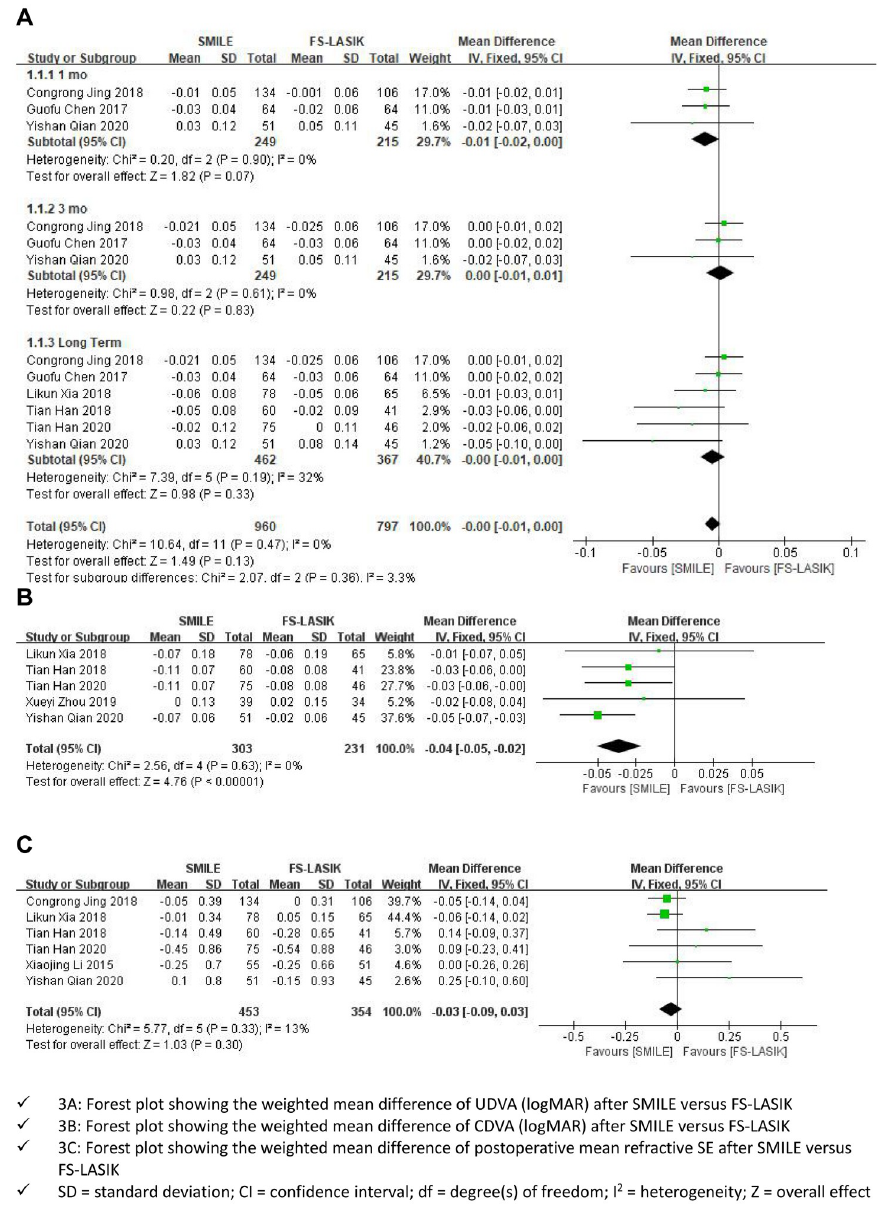
Fig 3. Primary outcomes